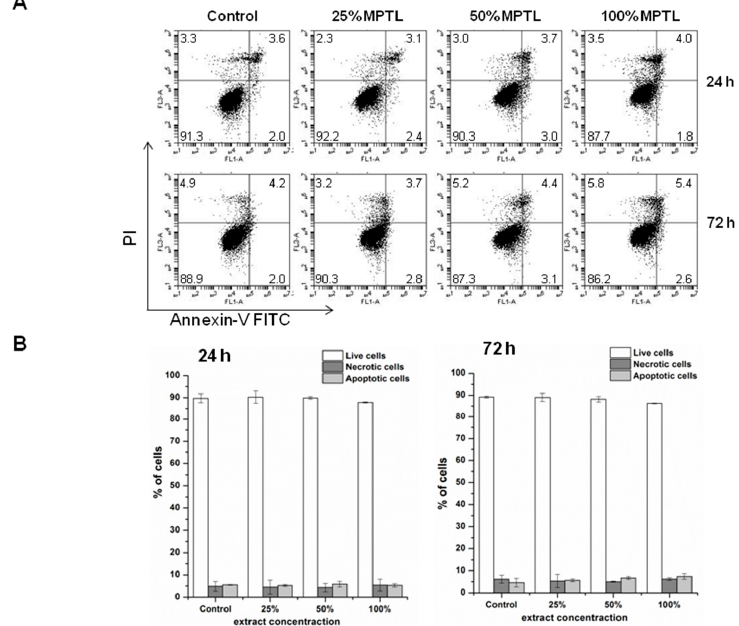
Figure 8. The effect of MPTL extracts on the induction of apoptotic and necrotic cell death of mouse embryonic fibroblast NIH 3T3 cells. Following MPTL extract treatment, cells were double-stained with Annexin V-FITC and propidium iodide (PI) and analyzed by flow cytometry. ( A ) Representative flow cytogram of Annexin V-FITC binding (abscissa) versus PI uptake (ordinate). The